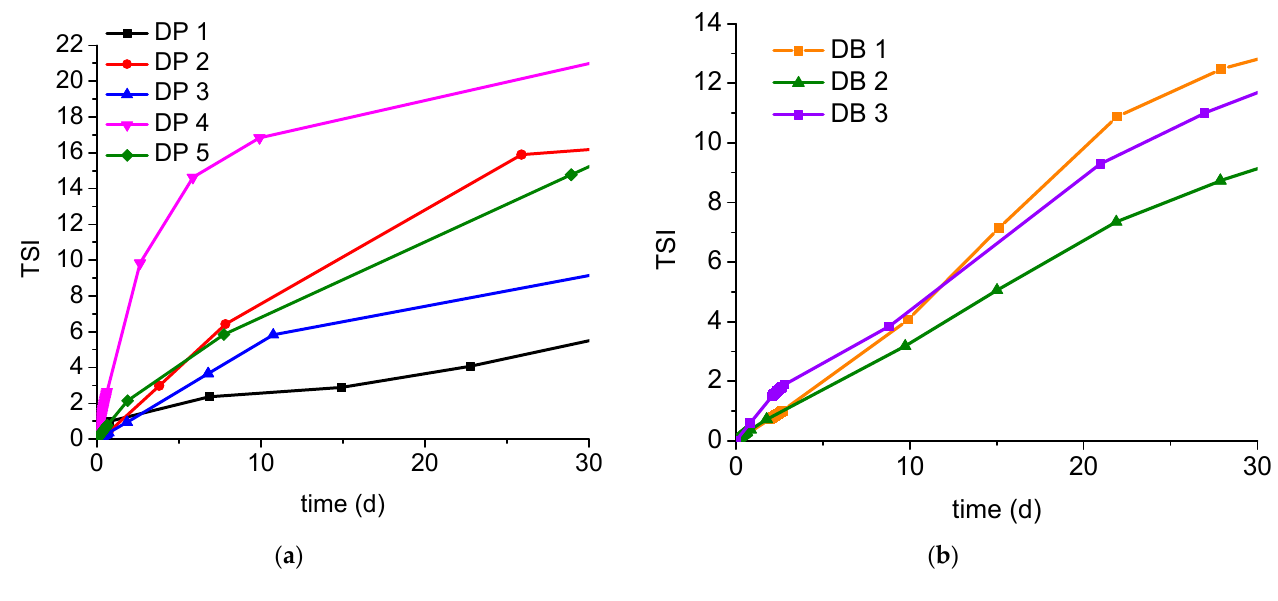
Figure 1. Comparison between Turbiscan Stability Index (TSI) of: ( a ) dispersions containing paraffin (petroleum and synthetic) waxes with constant additive packs (DP series); ( b ) dispersions containing beeswax with different emulsifiers. The lower the TSI value, the less changes inside the sample (DB series).